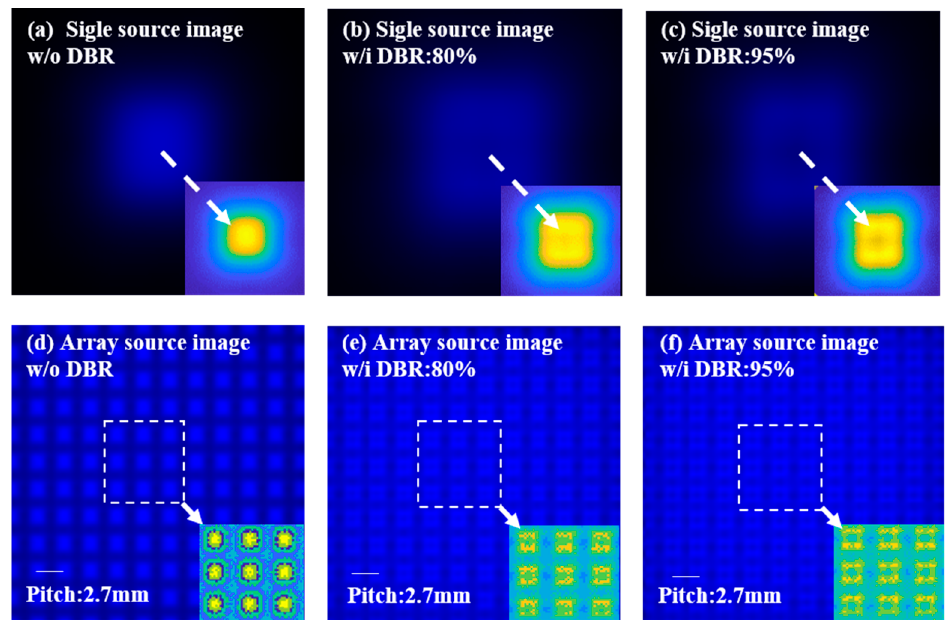
Figure 6. Fusion index of mini light-emitting diode array with various distributed Bragg reflector (DBR) structures.